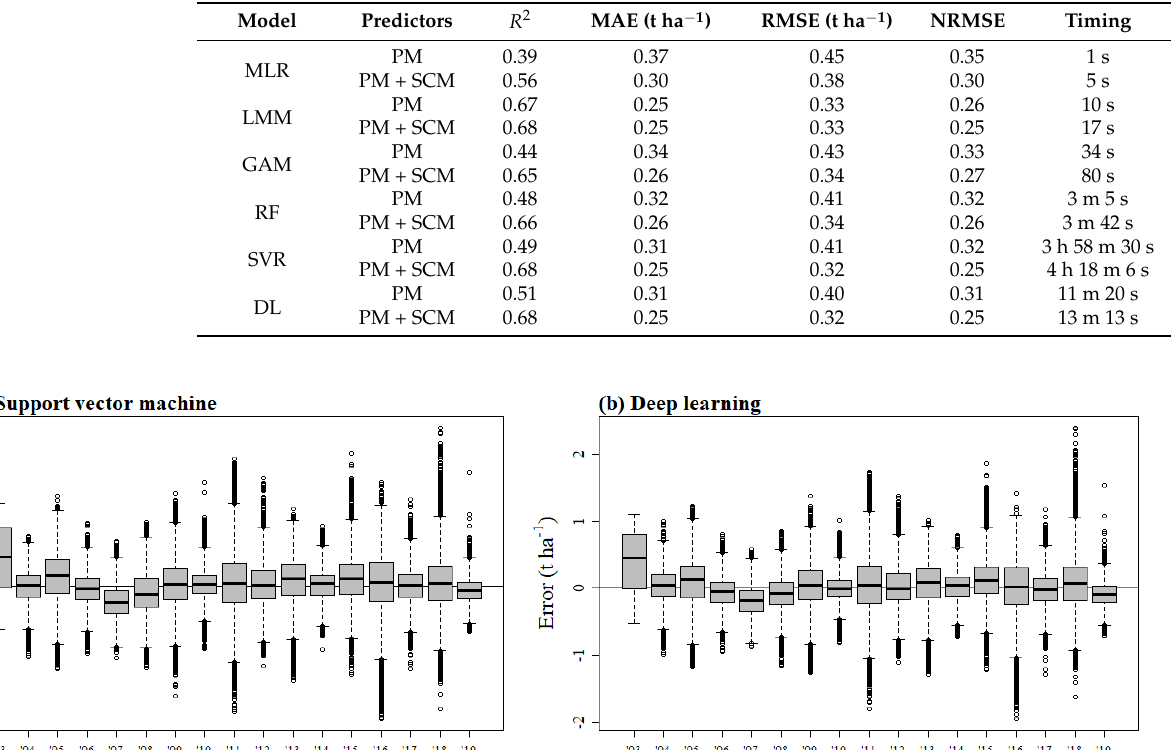
Table 4. Machine learning model comparison for hindcasting wheat yields in paddocks (using a 50– 50 train-test split on paddock-years). Models tested include multiple linear regression (MLR), gen- eralised additive model (GAM), linear mixed model (LMM), random forest (RF), support vector regression with radial basis functions (SVR) and deep learning (DL). Predictors used include phe- nological metrics (PM) and seasonal climate metrics (SCM). Timing is the computational time re- quired to fit the model to the training data (n = 205,889) on a Dell Latitude laptop with 2.8 GHz CPU and 32 GB RAM.